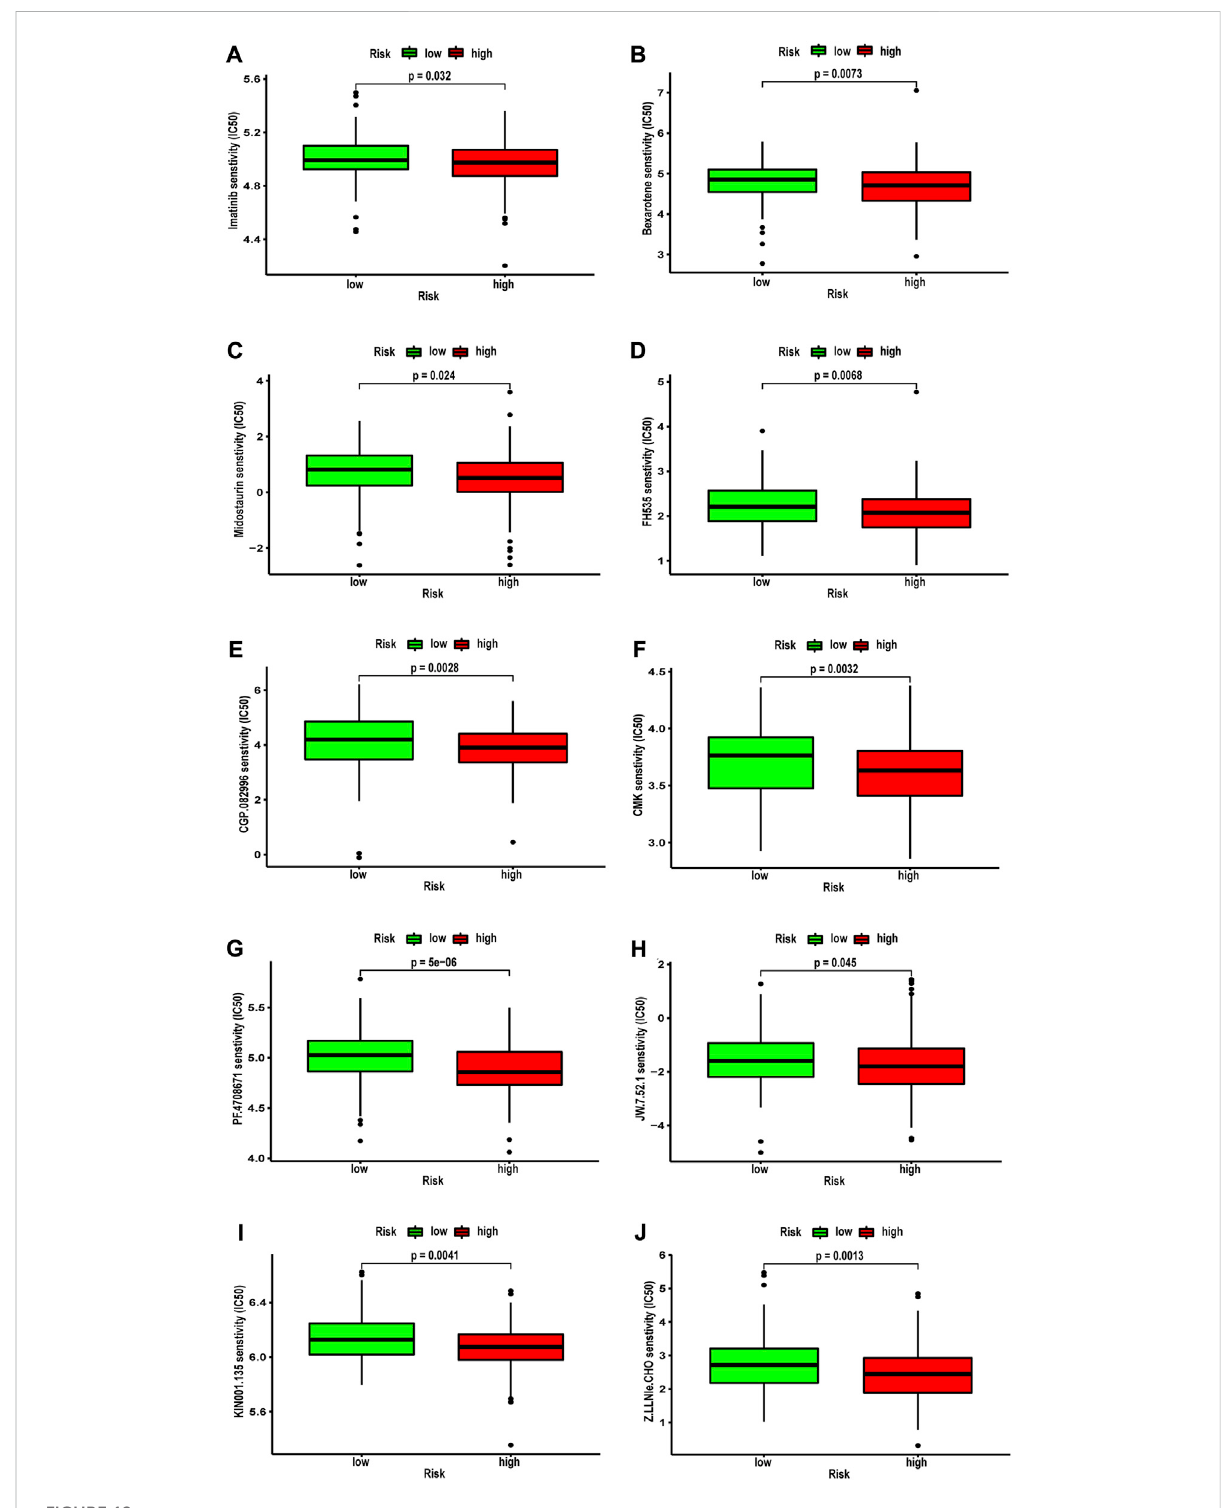
FIGURE 12 Correlation between NRG score and IC 50 values of antitumor drugs, including (A) imatinib, (B) bexarotene, (C) midostaurin, (D) FH535, (E) CGP.082996, (F) CMK, (G) PF.4708671, (H) JW.7.52.1, (I) KIN001.135, and (J)